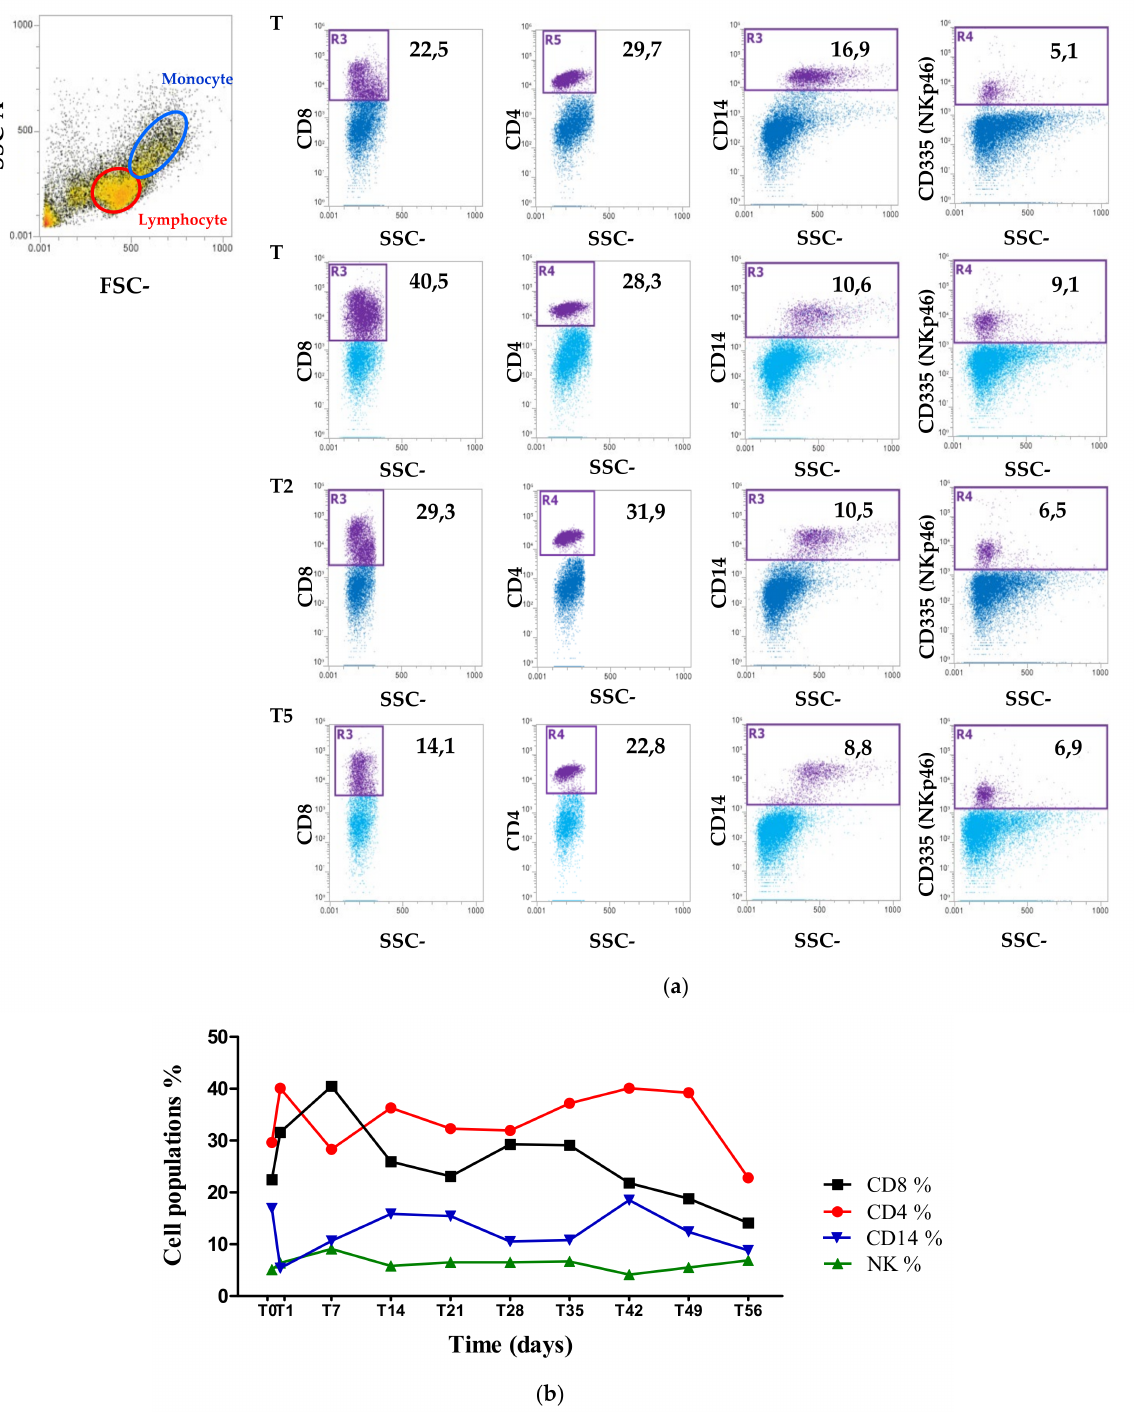
Figure 5. Flow cytometric analysis of immune cells population in PBMCs. ( a ) Representative dot plots showing the selection of lymphocytes and monocytes based on their SSC/FSC properties and the percentage of CD4 + , CD8 + , CD14 + and CD335 + (NK) cells at T0 (the day of the arrival at the Department of Veterinary Medicine), T1, T28 and T56. ( b ) Line plot that shows the trend of the CD4 + , CD8 + , CD14 + and CD335 + (NK) cell populations (%) at different time points from T0 to